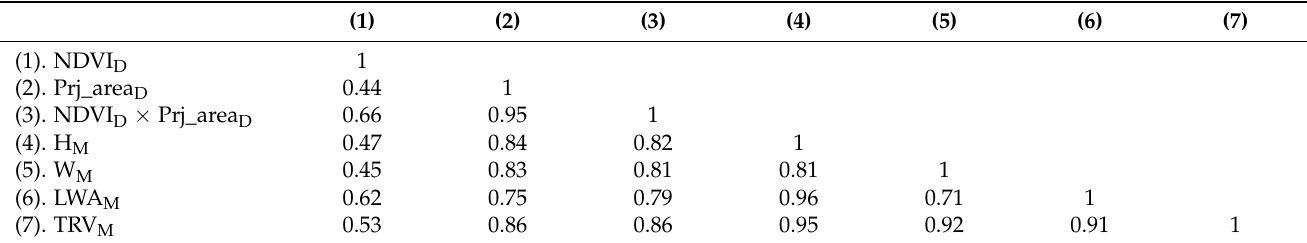
Table 4. Spearman’s rho correlation matrix for variables obtained using UAV.